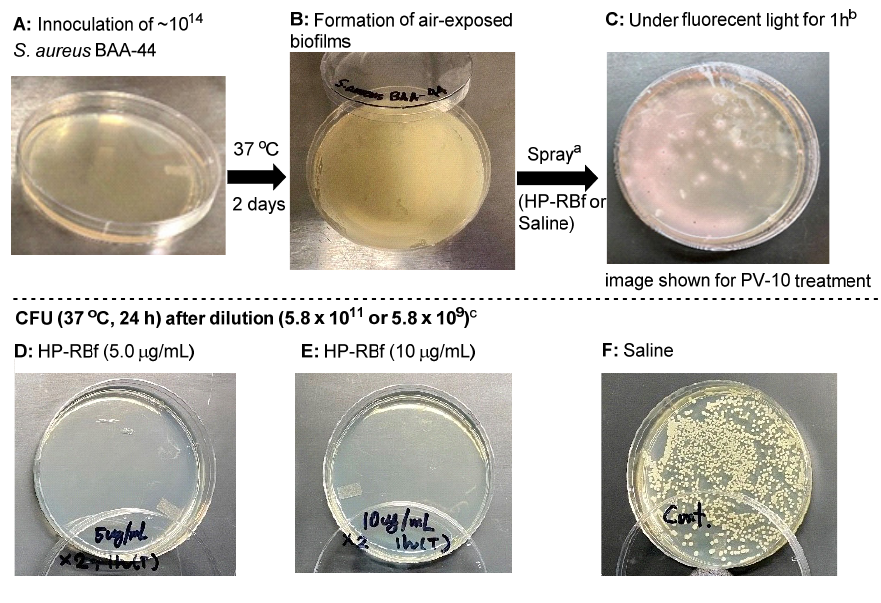
Figure 4. Effect of HP-RBf on air-exposed biofilms of S. aureus BAA-44 TM . a HP-RBf or saline was treated twice at Time 0 and 30 min (total treatment time: 1 h). b 17 W, 63.8 cm 2 fluorescent light was used. c CFU was counted after a 24 h incubation at 37 °C (see Table 3). Table 3. CFU after the treatment of HP-RBf for air-exposed biofilms of S. aureus BAA-44 TM a.